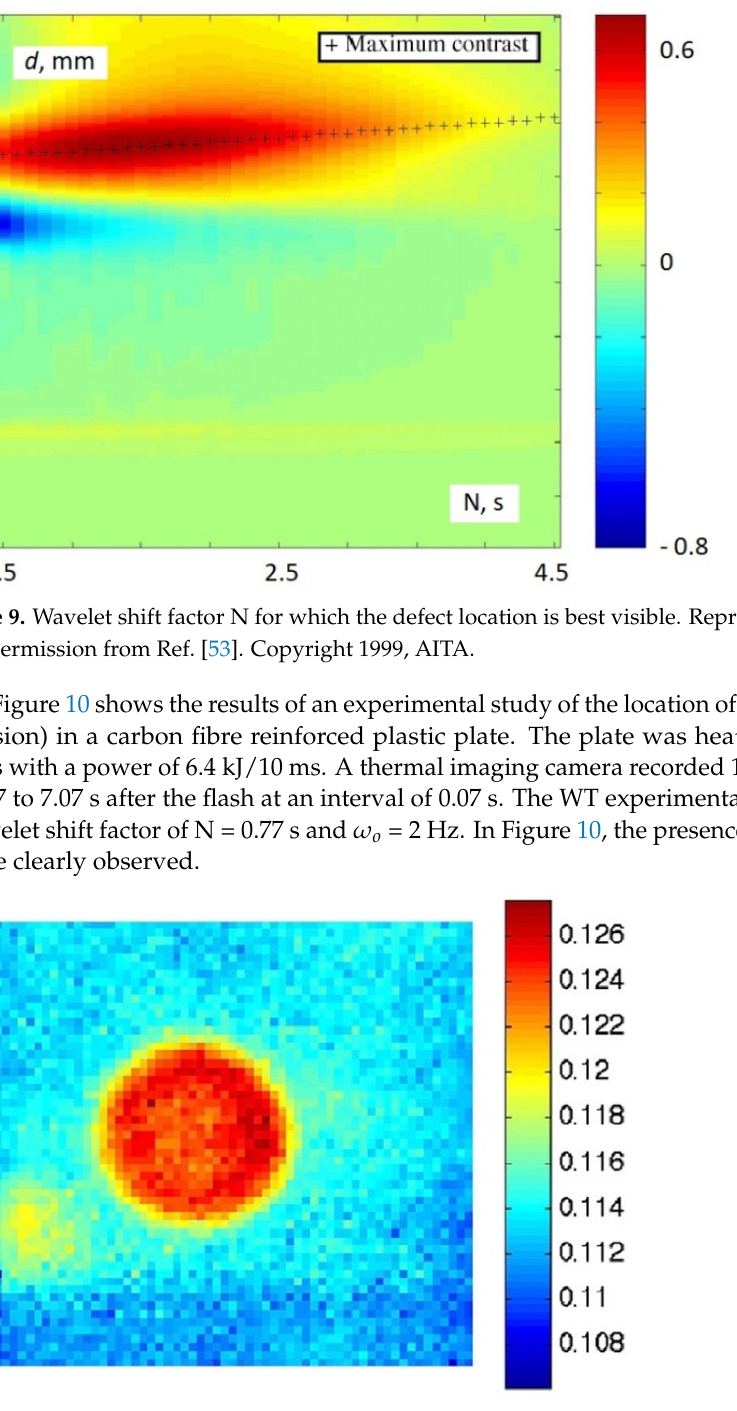
Figure 10. Results of applying the WT transformation to a carbon fibre reinforced plastic panel